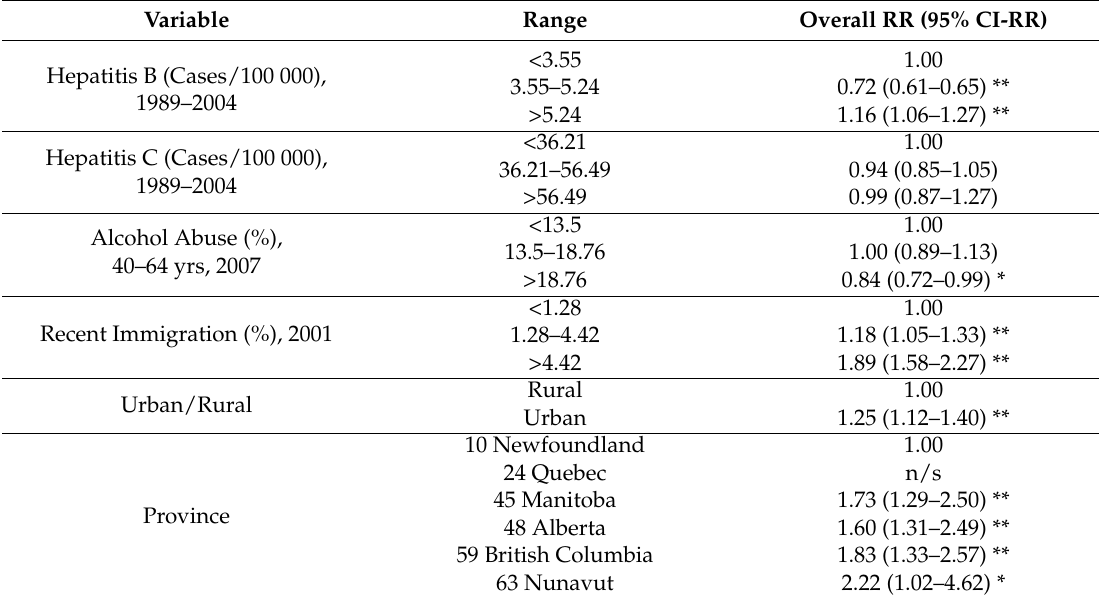
Table 3. Univariant Analysis Assessing the Impact of Socio-Demographic Factors on Liver Cancer Development within